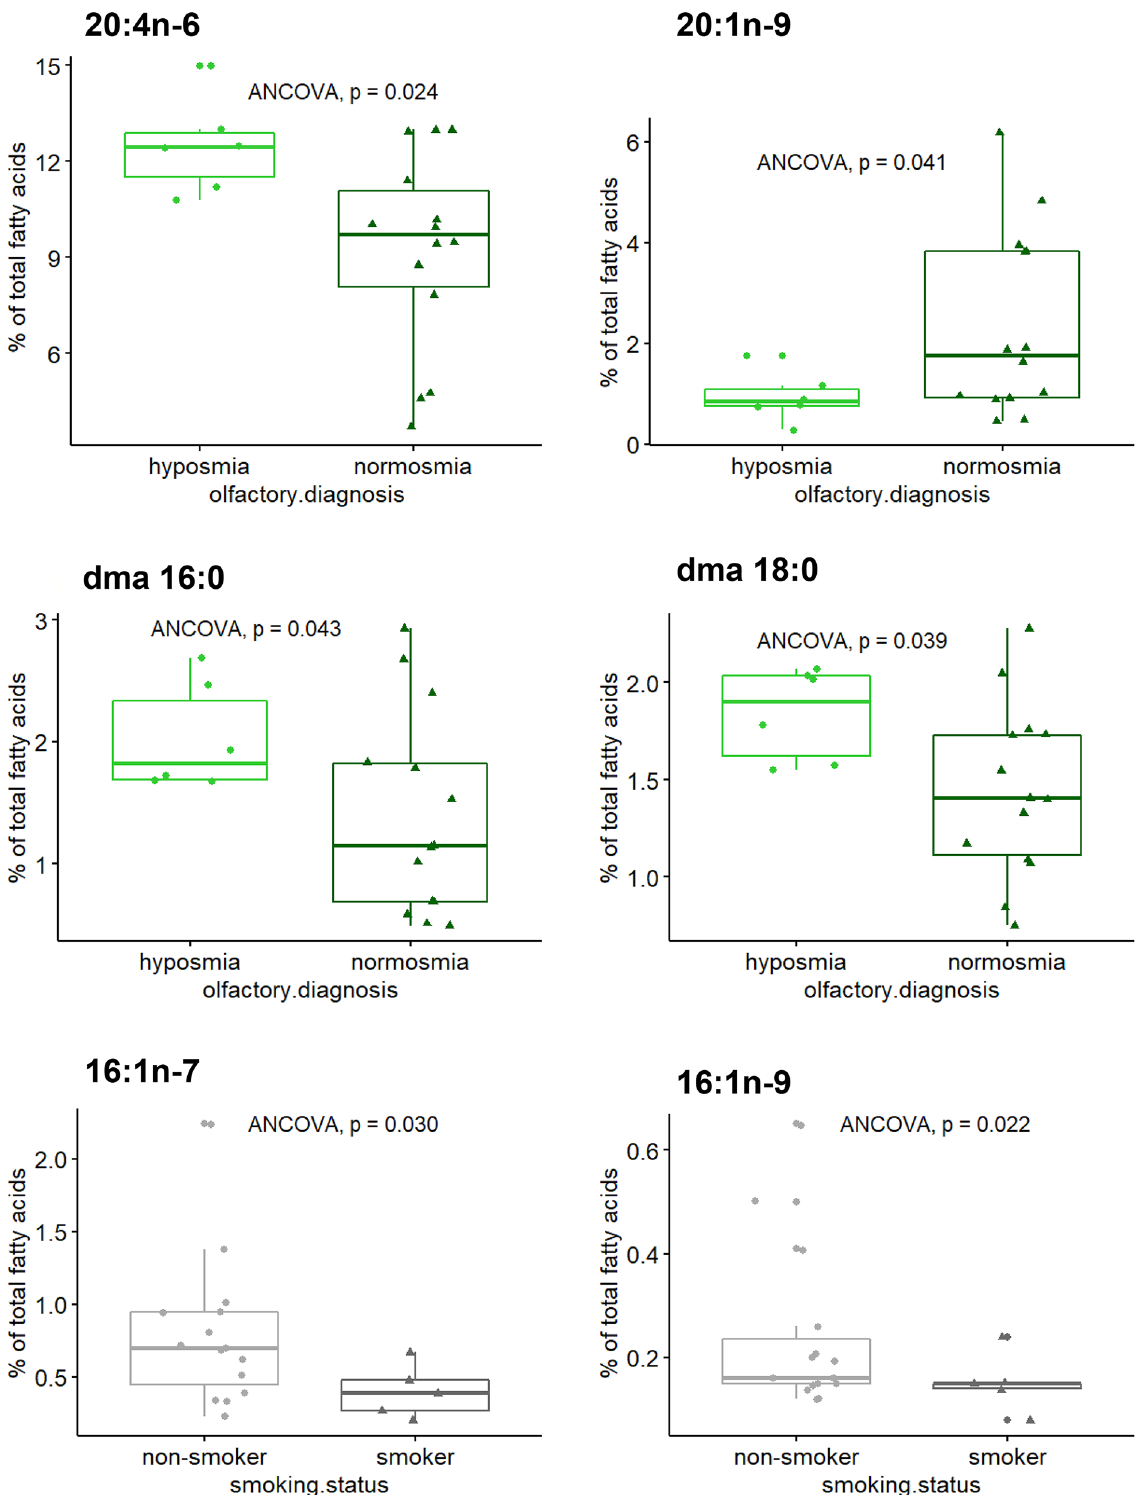
Figure 5. Significant associations between individual factors and nasal fatty acids estimated by type II ANCOVA. The results are presented as the median, first and third quartiles, and range (n = 20). dma dimethyl